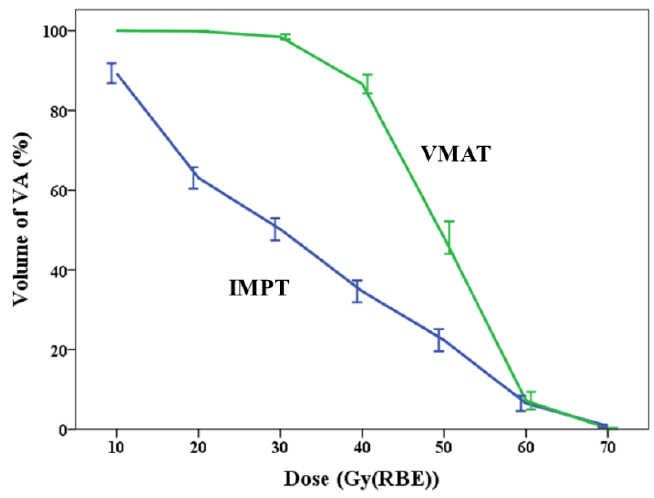
Figure 1. Differences in dose–volume indices of V10 to V70 to vertebral arteries between intensity modulated proton therapy (IMPT, blue line) and volumetric modulated arc therapy (VMAT, green line). (Error bar = ± 1 S.E). Table 2. Summary of differences in doses to vertebral arteries between intensity modulated proton therapy and volumetric modulated arc therapy plans. IMPT VMAT Paired Differences p